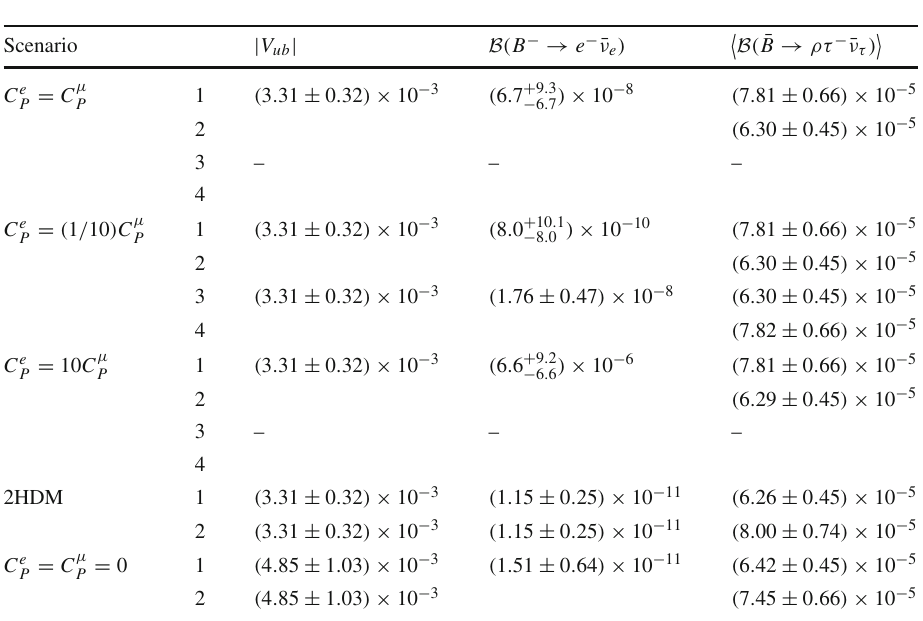
μ and C τ for the scenarios discussed in the text P P (cid:28) in the